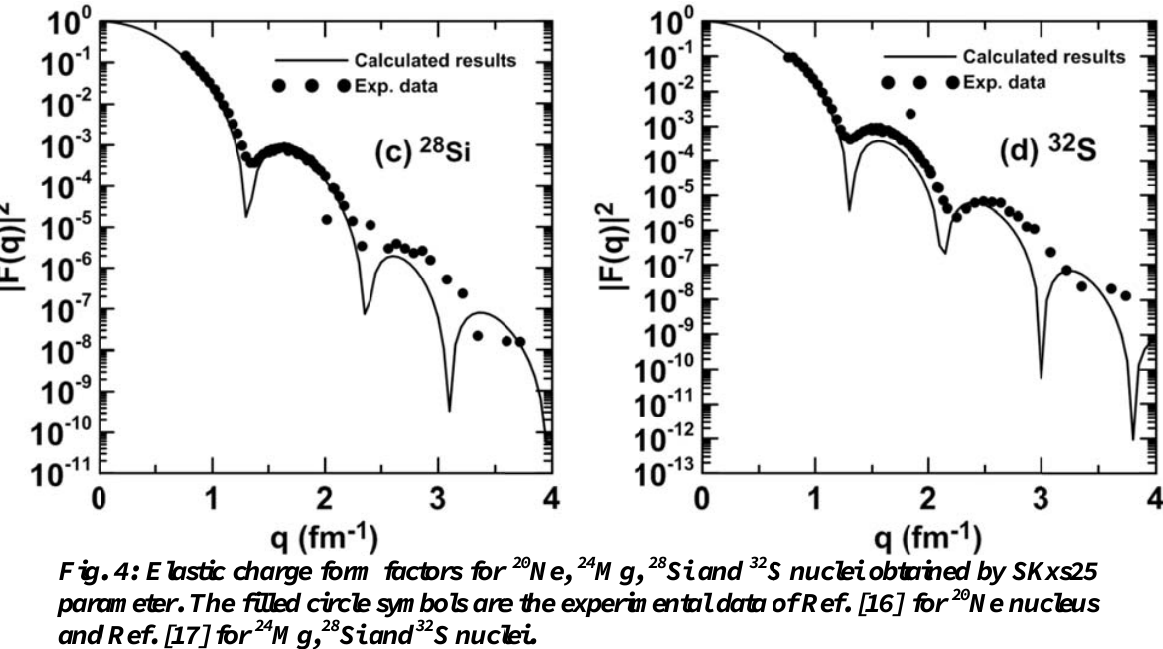
m factors for symbols are and 32 S nucl harge, proto